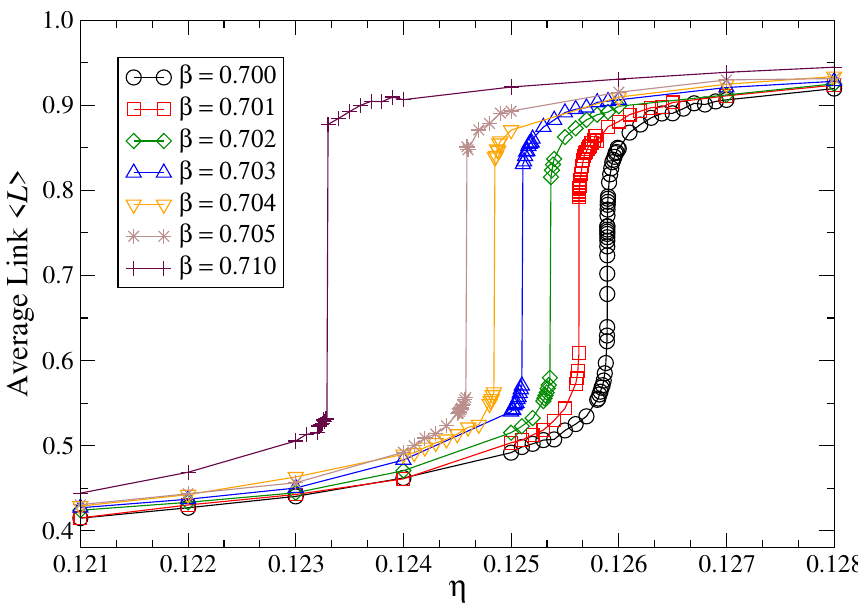
Figure 3 . η dependence of h L i at µ = 0 for β ∈ [0 . 700 , 0 . 710] on a lattice whose volume is V = 1024 3